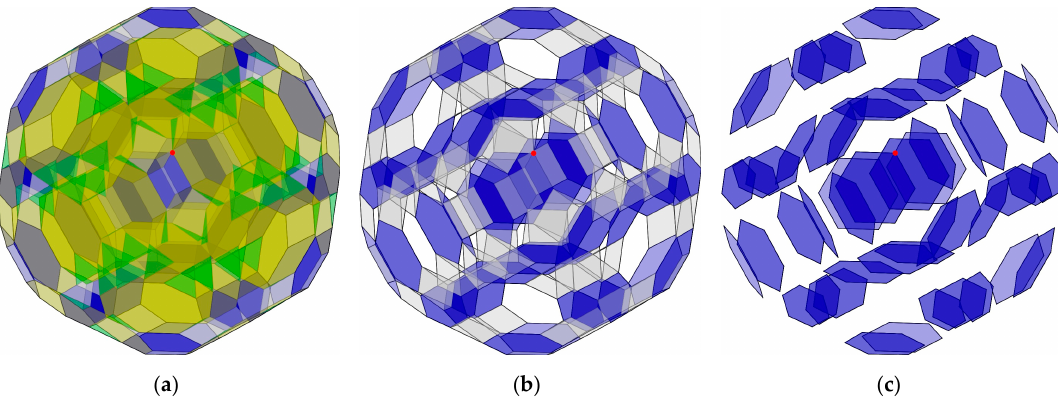
Figure 4. Reducing the complexity of an object via filtering: ( a ) rendering of the object in full detail; ( b ) result of applying two types of face filters; and ( c ) result of applying an edge filter and another face filter.